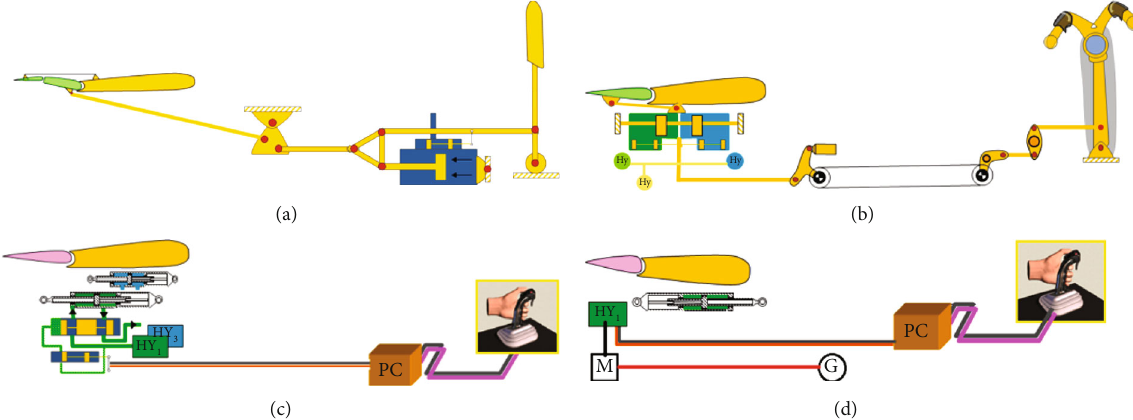
Figure 1: Aircraft control system with (a) hydraulic booster, (b) hydromechanical servo control, (c) electrical fl ight control, (d) electro- hydrostatic actuator. Adapted from